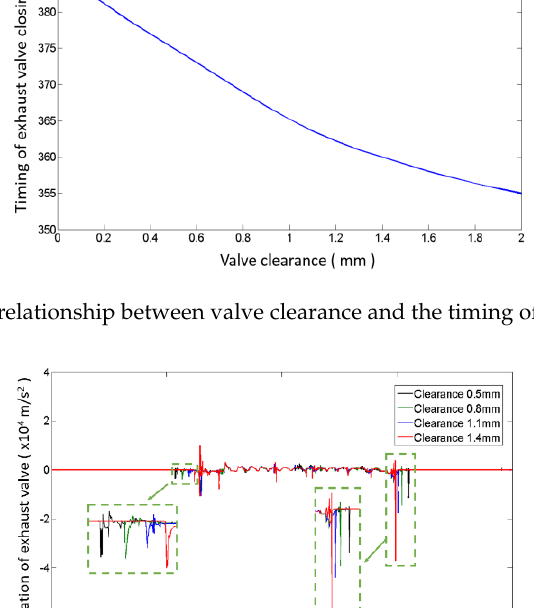
Figure 5. Valve lift of different clearances.